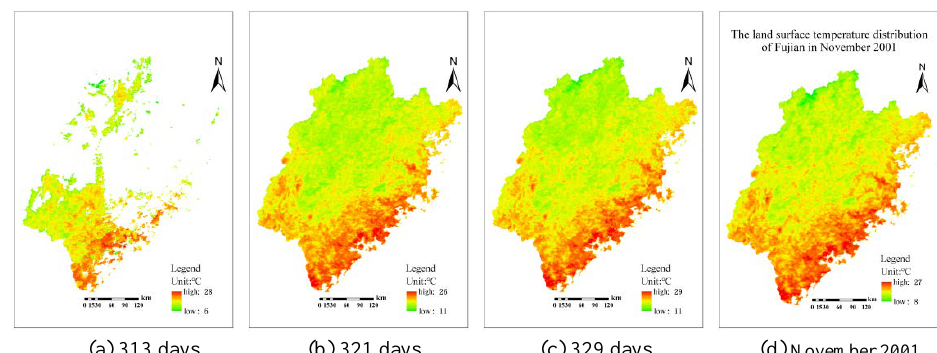
Figure 1. The 8-days LST products in the days of 313, 321 and 329 on November 2001 in Fujian Province (a, b, c) and the monthly synthetic LST map based on the three images